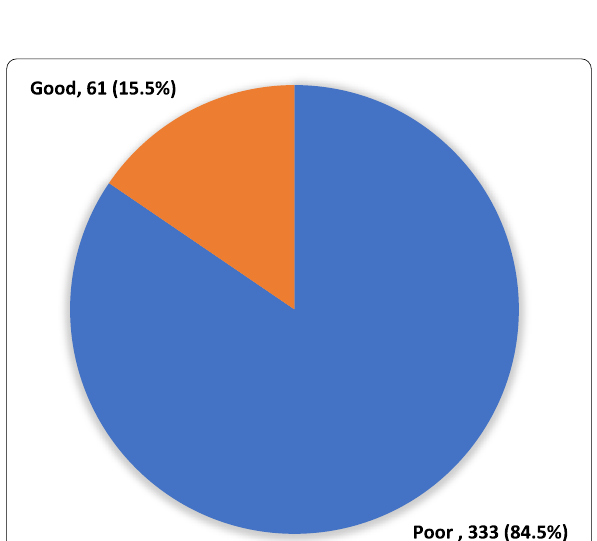
Fig. 1 Overall awareness level regarding first aid management of epistaxis among school teachers in Aseer Region, Saudi